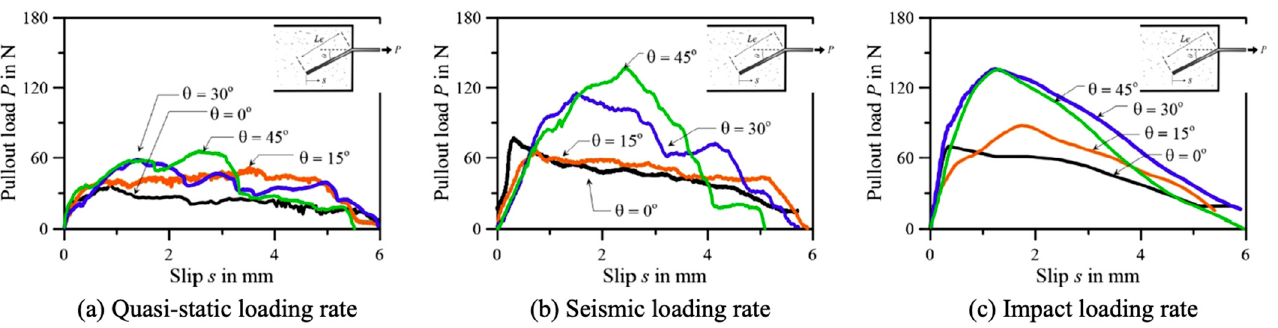
Figure 18. Average pull-out load vs. slip curves for S fibres embedded in UHPC under several loading rates and inclination angles: ( a ) quasi-static loading rate; ( b ) seismic loading rate; and ( c ) impact loading rate [26].